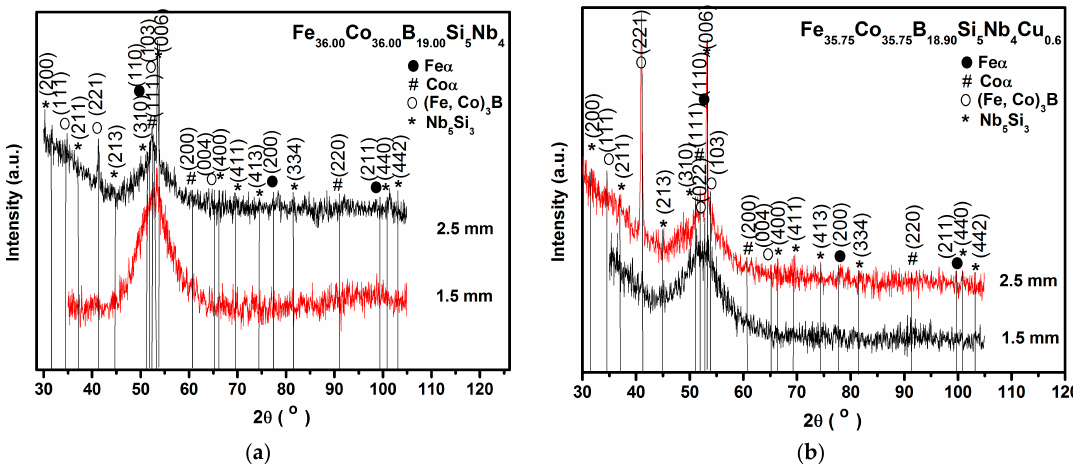
Figure 2. X-ray diffraction patterns of ( a ) Fe 36.00 Co 36.00 B 19.00 Si 5 Nb 4 and ( b ) Fe 35.75 Co 35.75 B 18.90 Si 5 Nb 4 Cu 0.6 alloys in rod form with diameters of 1.5 and 2.5 mm.